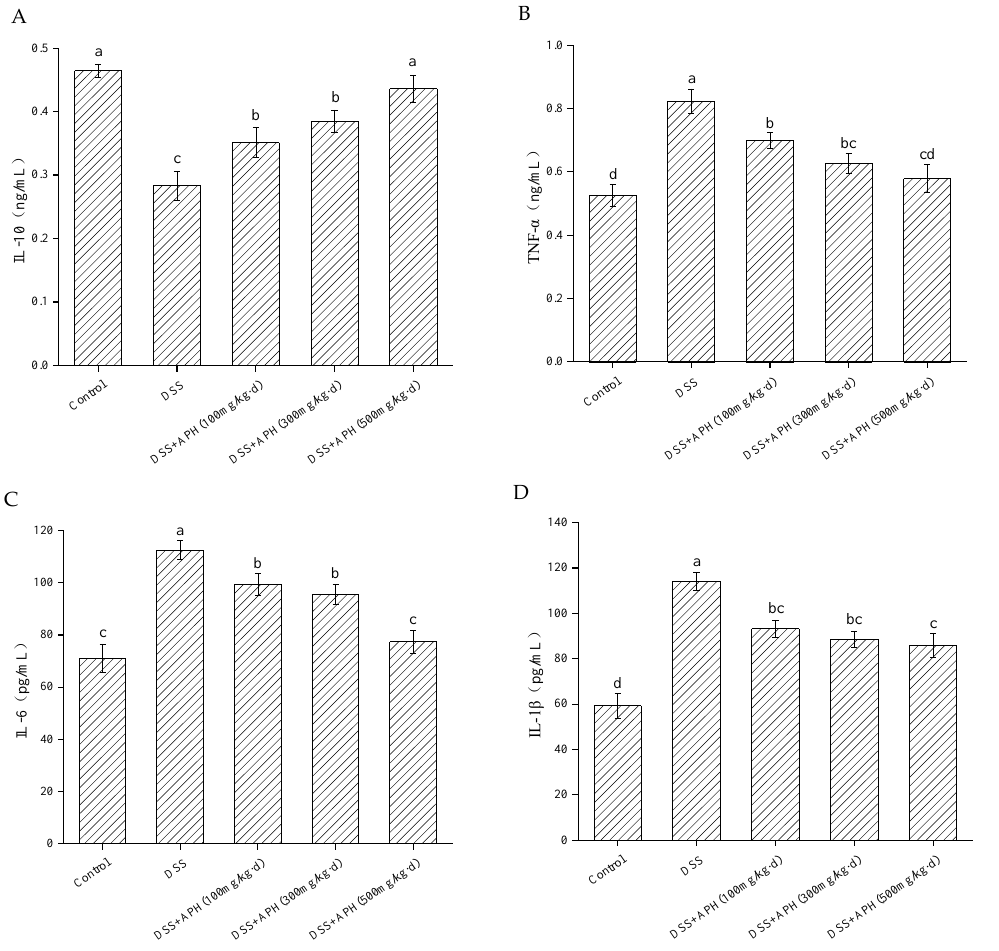
Figure 3. Effects of APH on the inflammatory cytokines, including the serum levels of IL-10 ( A ), TNF- α ( B ), IL-6 ( C ) and IL-1 β ( D ). Data are expressed as mean ± SD ( n = 8). Different letters indicate significant differences ( p < 0.05).